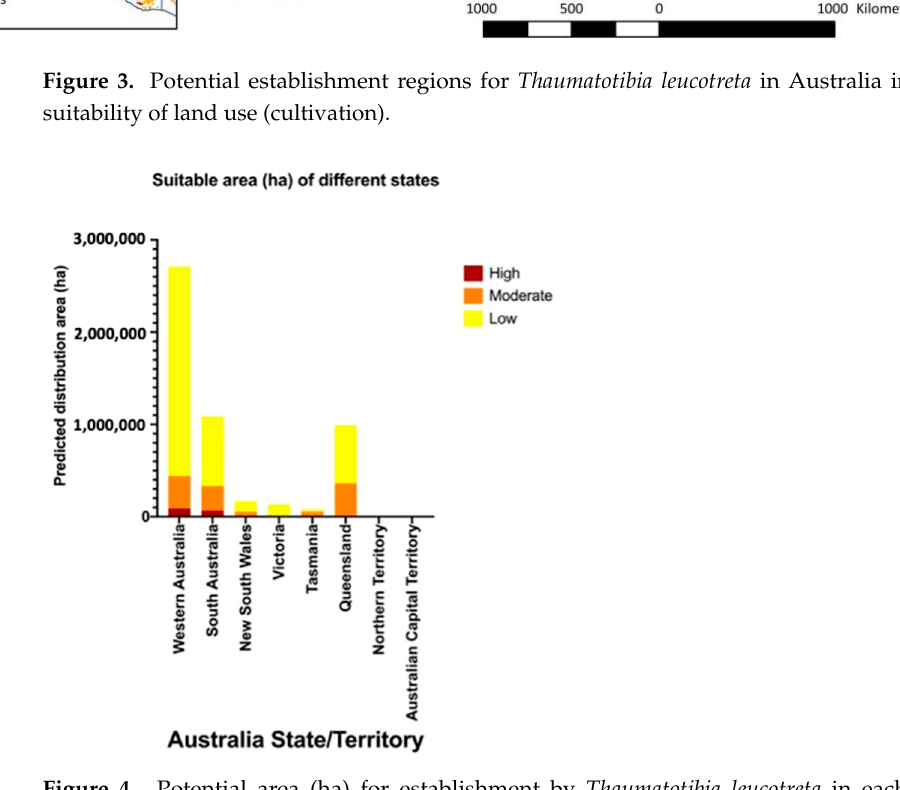
Figure 4. Potential area (ha) for establishment by Thaumatotibia leucotreta in each Australian state/ter- ritory. Table 2. Summary of potential establishment areas (ha) for Thaumatotibia leucotreta in each Austral- ian state/territory.